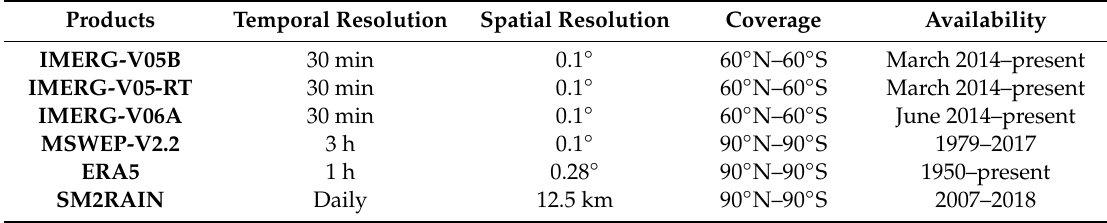
Table 1. Characteristics of the precipitation